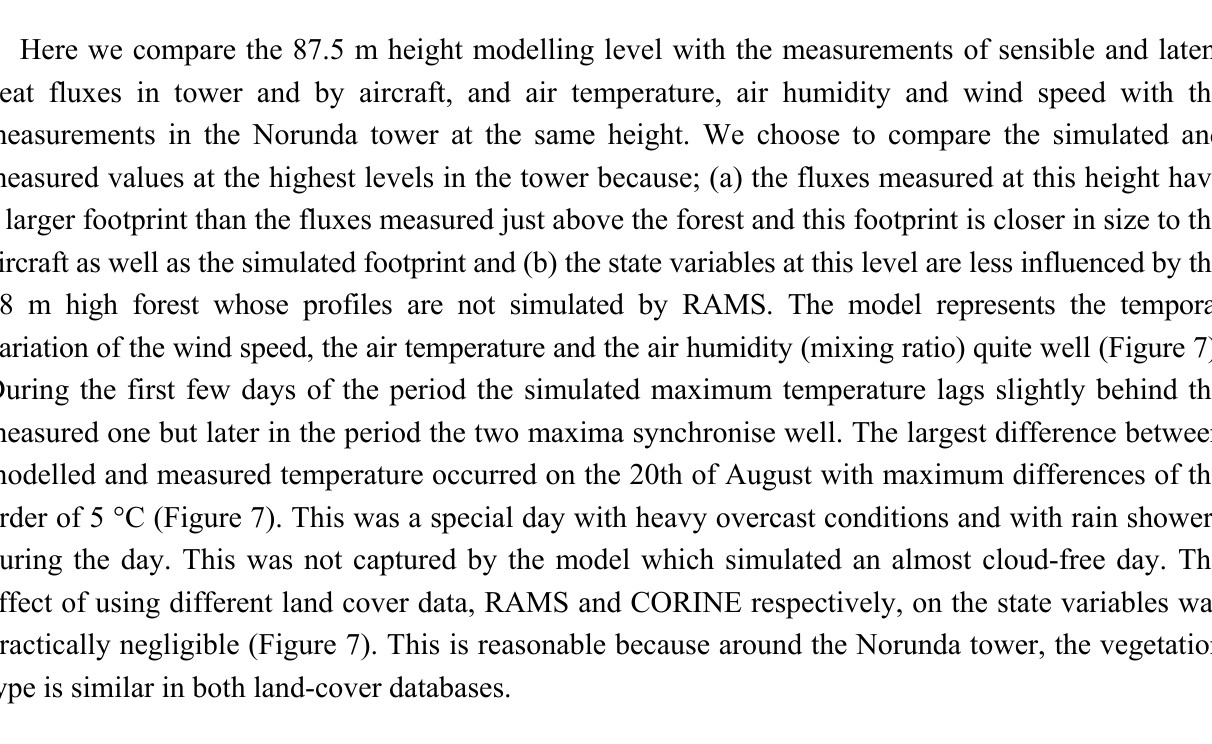
Figure 7. Measured and simulated wind speed (upper), air temperature (middle) and air humidity mixing ratio (lower) for the ten-day period in August